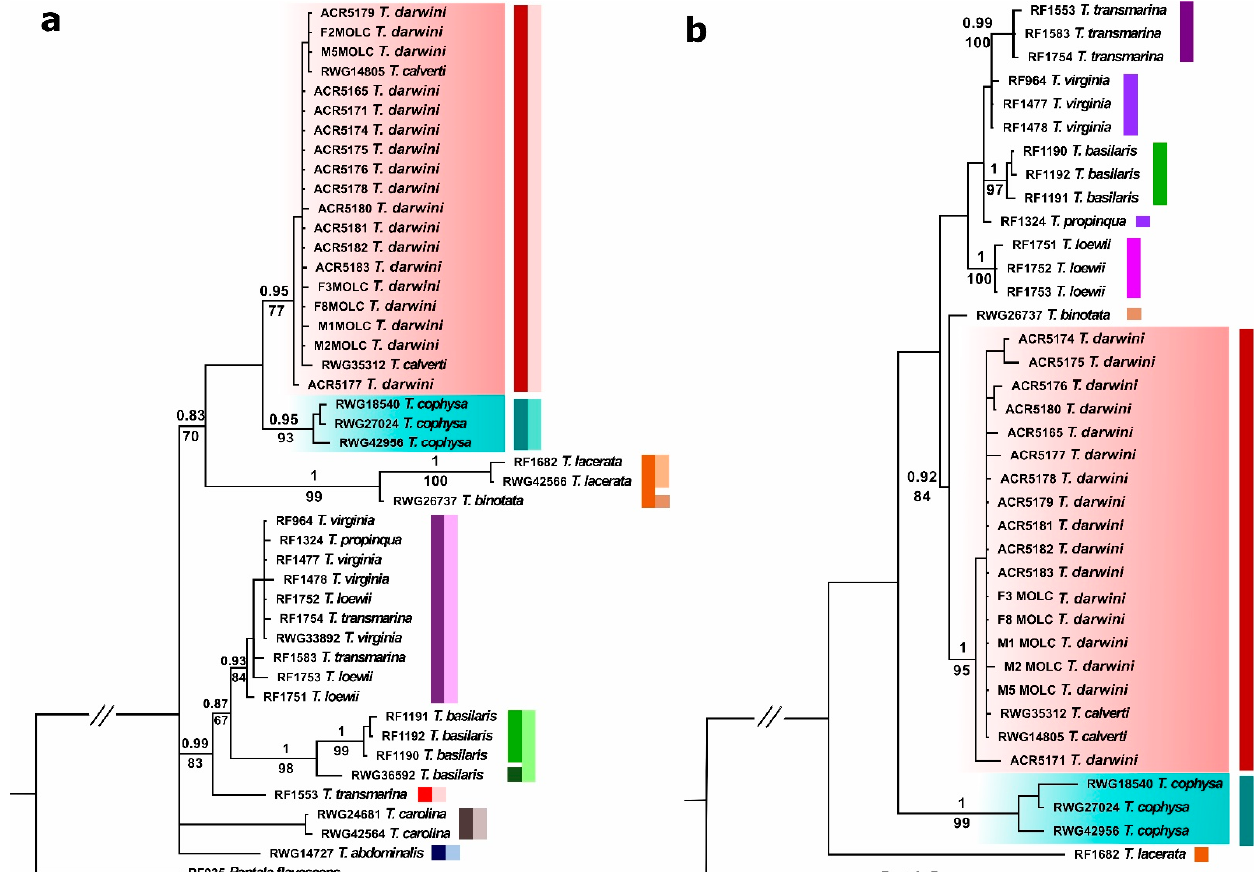
Figure 1. Tree representing the phylogenetic relationships among the Tramea species analyzed in this study, using ( a ) mtDNA (16S + COI) and ( b ) nDNA (ITS) data. Numbers above and below branches represent Bayesian posterior probability values and ML bootstrap values, respectively. The clade comprising the Tramea from Galapagos and T. calverti is highlighted in pink, and the T. cophysa clade appears highlighted in blue. The colored bars by each clade represent the proposed species delimitation based on Automated Barcode Gap Detection (ABGD) analyses, where each color represents a delimited species. For the mtDNA markers, the dark and light colour bars represent species delimitations according to COI and 16S datasets, respectively.